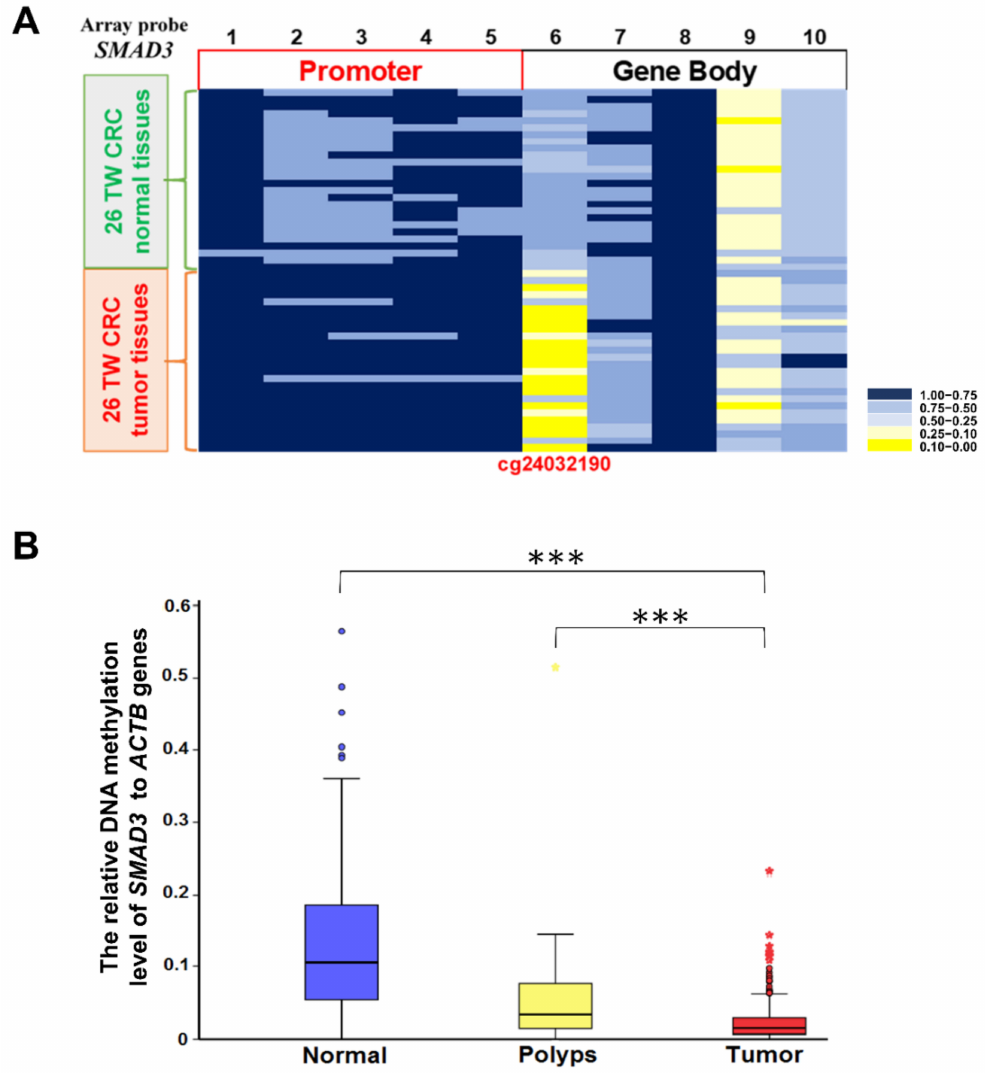
Figure 2. Methylation levels in Taiwanese patients with colorectal carcinoma (CRC). ( A ) Di ff erentially methylated CpG heatmap of mothers against decapentaplegic homolog 3 ( SMAD3 ) in 26 paired CRC patients. Methylation levels (average β values) at di ff erentially methylated loci were identified